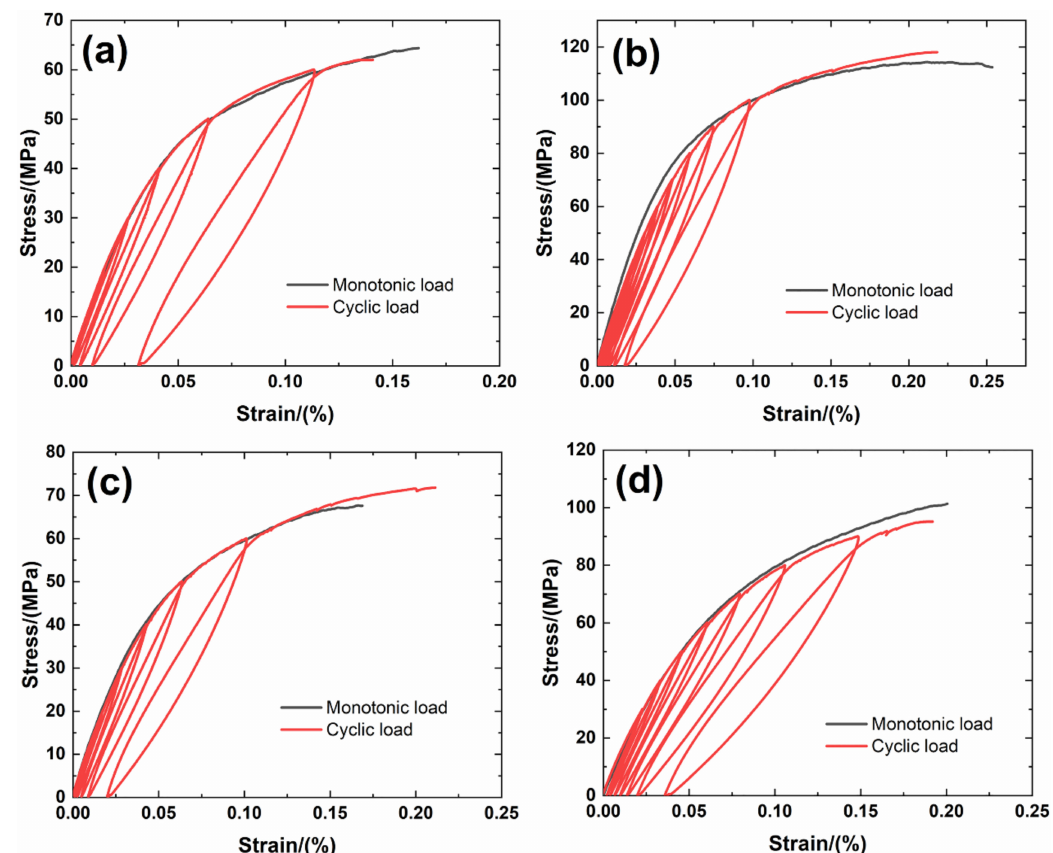
Figure 6. Monotonic and cyclic loading/unloading tensile stress-strain curves corresponding to different 3D needle-punched C/SiC composites with different fabric preforms ( a ) Type 1; ( b ) Type 2; ( c ) Type 3; and ( d ) Type 4.